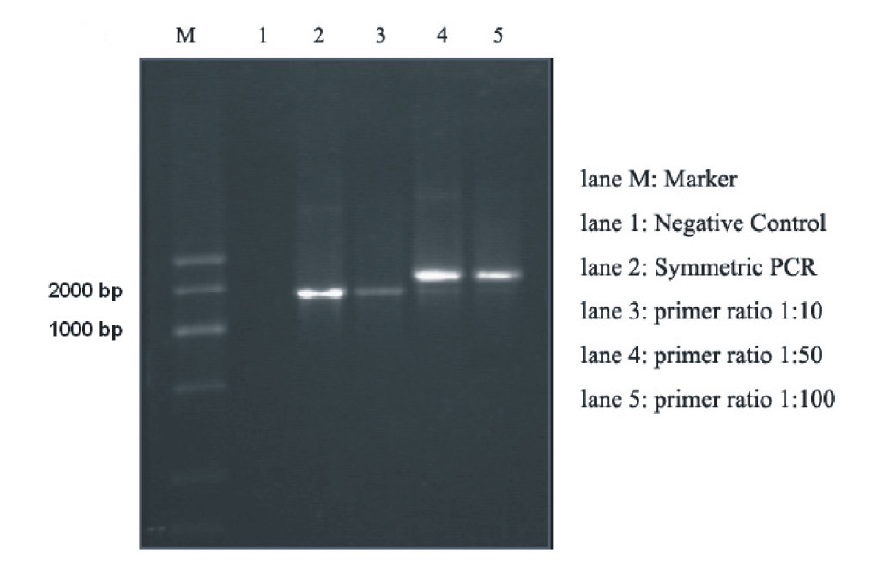
Figure 1. Electrophoresis patterns of symmetric and asymmetric PCR products in 1% agarose gel. Lane M, DNA Marker G (300~2500bp); lane 1, negative control; lane 2, 1888-bp amplified using 10 µ M S525 and 10 µ M AS2395 as primers; lane 3 asymmetrically amplified using 1 µ M S525 and 10 µ M AS2395; lane 4 asymmetrically amplified using 0.2 µ M S525 and 10 µ M AS2395; lane 5 asymmetrically amplified using 0.1 µ M S525 and 10 µ M AS2395.